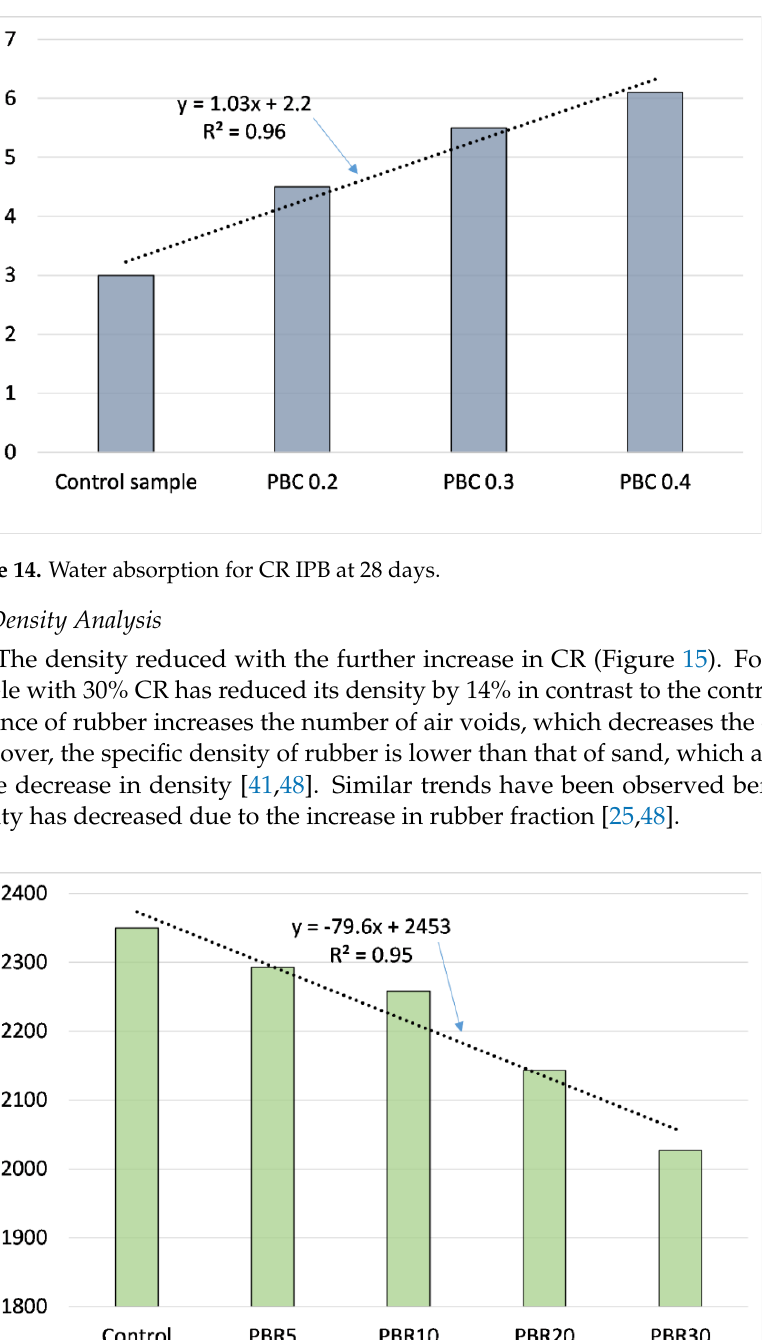
Figure 13. Water absorption for CR IPB at 28 days.